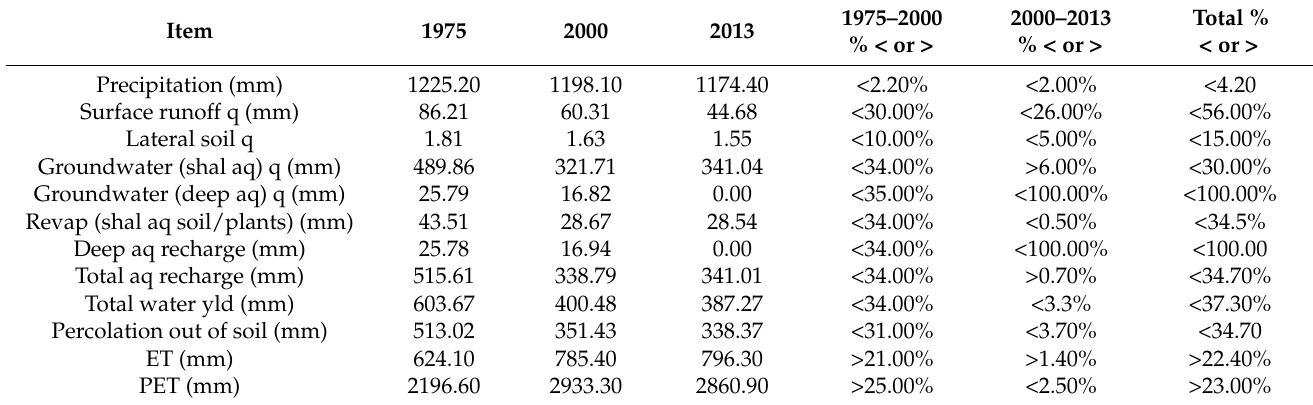
Table 7. Annual summary and percentage differences of important hydrological